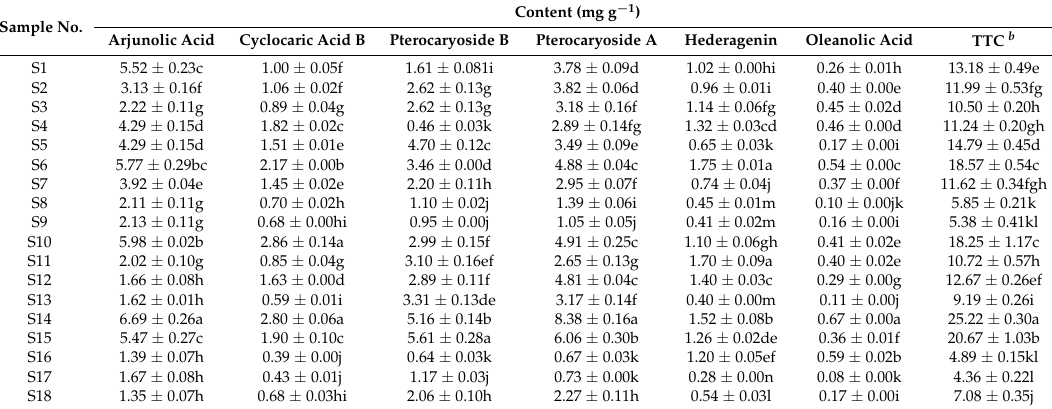
a Data are expressed as mean ± SD of duplicate experiments. Different letters indicate significant differences among the C. paliurus from different geographic regions in flavonoid content ( p ≤ 0.05 by Duncan’s test); b TFC: content of total seven flavonoids. Table 6. Quantitative determination of six triterpenoids in 18 samples of C. paliurus leaves a . Sample